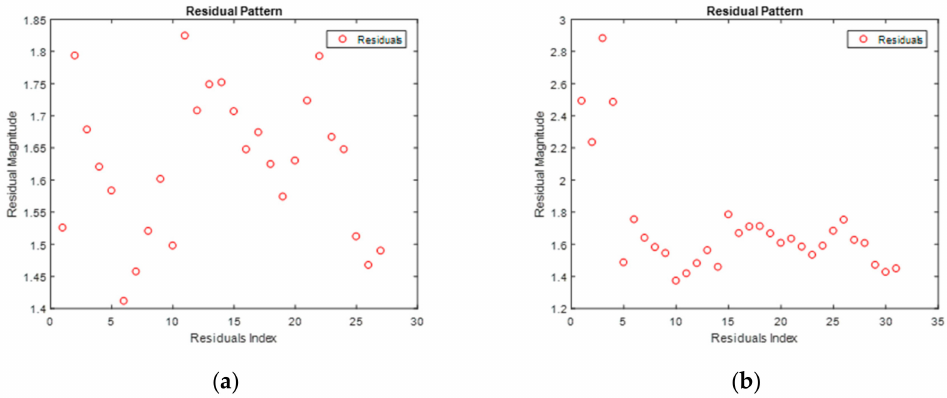
Figure 3. Residuals Pattern: ( a ) without Run-outs; ( b ) with